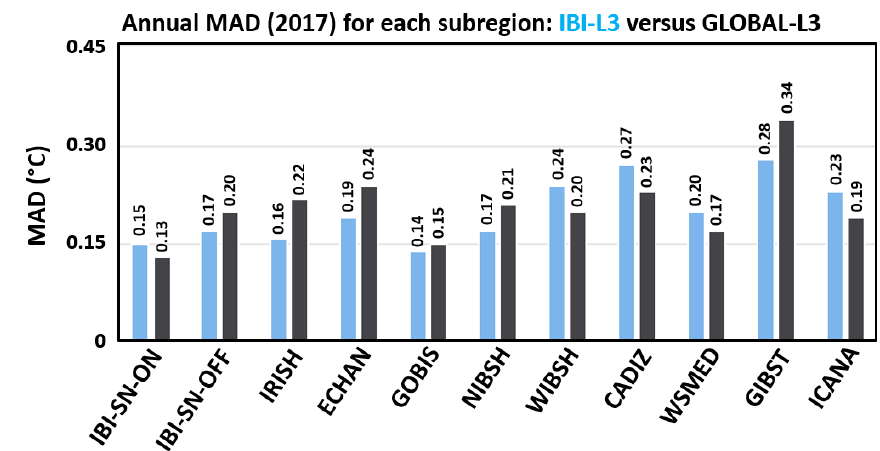
Figure 3. Annual (2017) mean absolute difference (MAD) of SST, spatially averaged for each subregion (defined in Fig. 1a), between IBI (GLOBAL) and satellite L3 observations, represented by blue (black) columns. IBI-SN-ON (IBI-SN-OFF) represents the area where the spectral nudging technique was (was not)